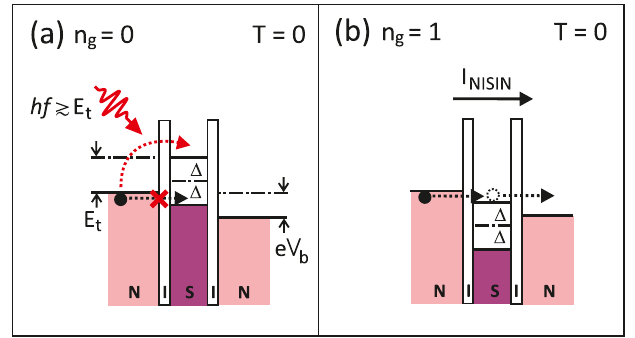
Figure 2. Energy diagram of the NISIN SET at zero temperature. ( a ) At n g = 0 and small bias voltages, the electron tunneling to the island is prohibited by the energy barrier E t , while absorption of a photon with energy E ph ≥ E t results in bringing one quasiparticle to the island (red dotted arrow); ( b ) When n g = 1, the height of the tunnel barrier is reduced and applying a small bias voltage results in the finite tunneling current I NISIN